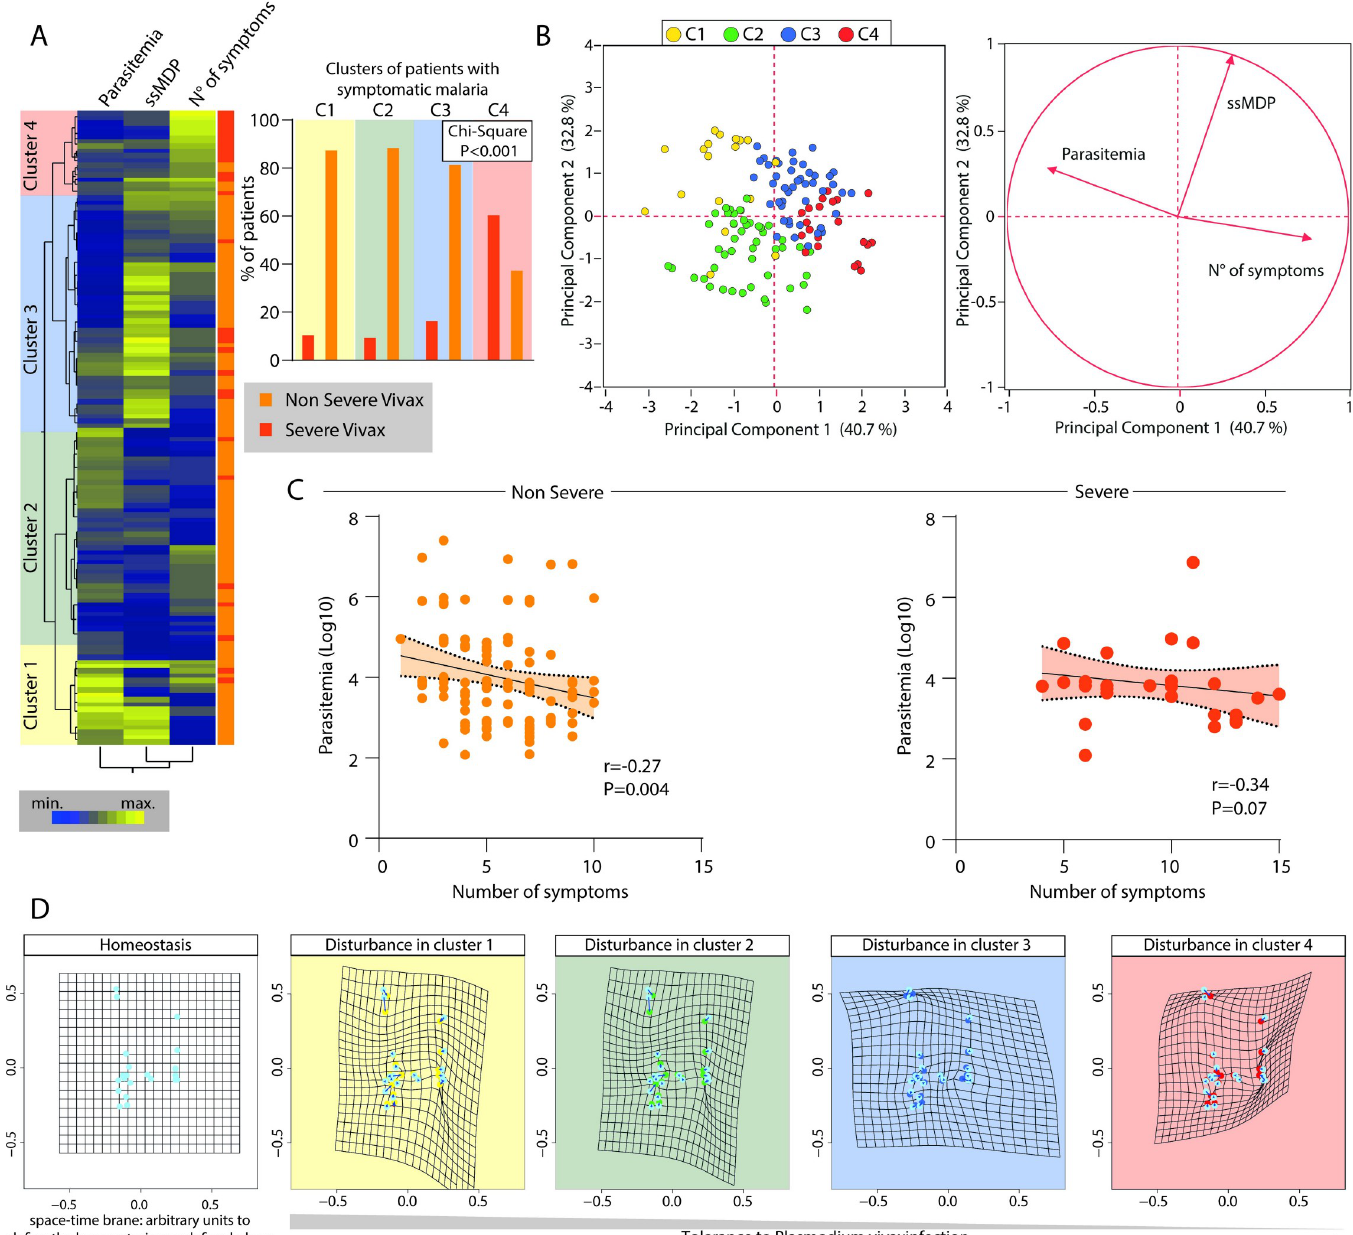
Fig 8. Characterizing disease tolerance in Plasmodium vivax malaria. (A) Left panel: A two-way hierarchical cluster analysis was employed to characterize the overall profiles of parasitemia, systemic inflammatory disturbance (ssMDP) and the number of symptoms in Plasmodium vivax patients presenting with either severe (n = 28) or non-severe disease (n = 106). Right panel: A Chi-Square test was used to test the proportion of severe vivax patients in each cluster identified. (B) A principal component (PCA) model (left panel) with a vector plot (right panel) was used to demonstrate the influence of each indicated parameter on the distribution of the data. Colors indicate the clusters identified in panel (A). (C) Patients were segregated according to malaria severity and a Spearman correlation analysis was performed to identify the association between parasitemia and number of symptoms (N˚ of symptoms). (D) A space-time deformity model based on the relativity theory of gravity was employed to visualize the impact of each plasma marker and tissue damage marker on disturbance of the homeostasis (defined as space-time brane in the control group). See Methods for details on the mathematical model. Each dot represents a marker, and groups of patients were separated based on the cluster analyses shown in (A).